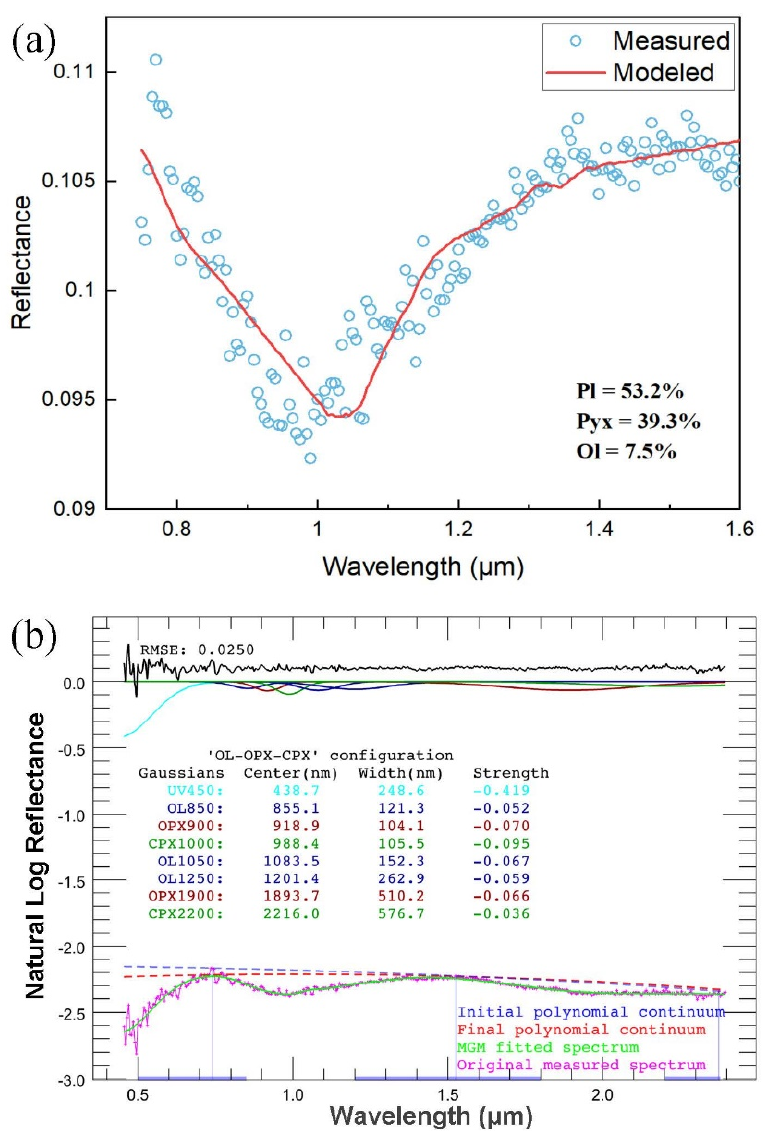
Figure 7. The estimated results of CR-1 by the Hapke model ( a ) and modified Gaussian model ( b ), whose spectrum was detected by VNIS SF.